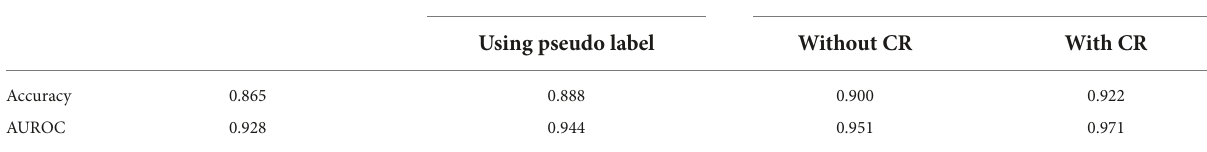
TABLE 5 Performance of disassembled OpenMatch with different experimental